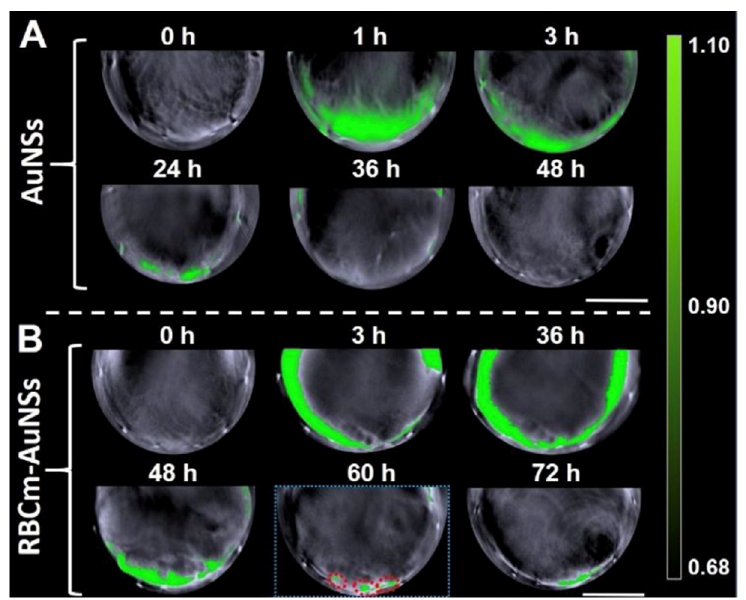
Figure 11. PA images of the two groups of mice after injection of ( A ) AuNSs and ( B ) RBCm-AuNSs. The images cover different periods of time from 0 h until 48 h [145].